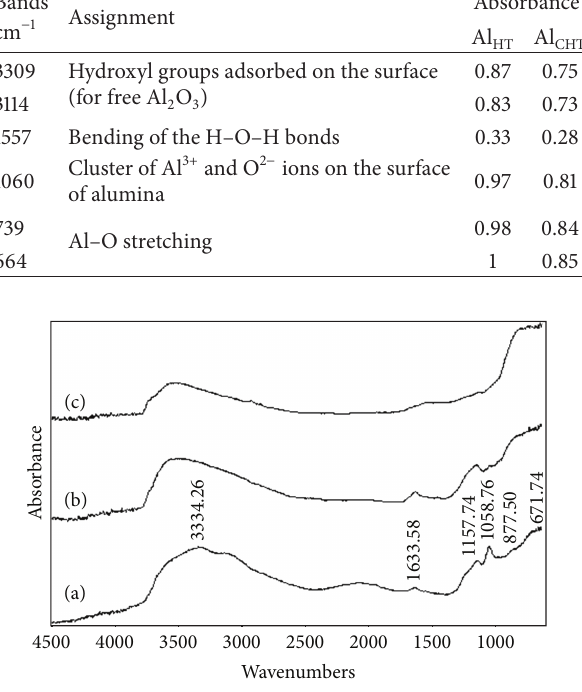
Figure 1: DRIFT spectra of (a) Al, (b) Al C500 , and (c) Al C1000 .